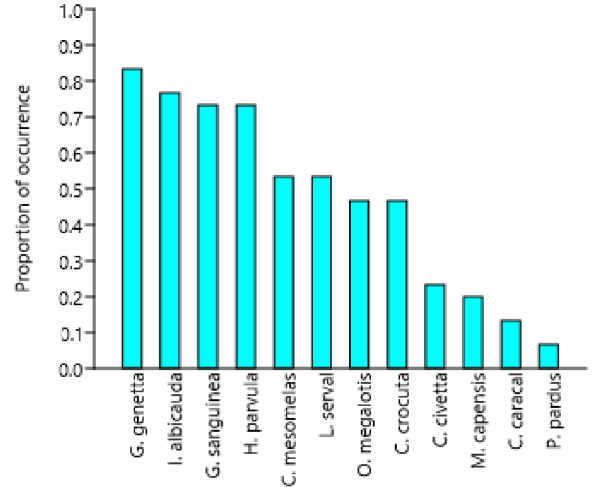
Bold numbers in the P value indicate